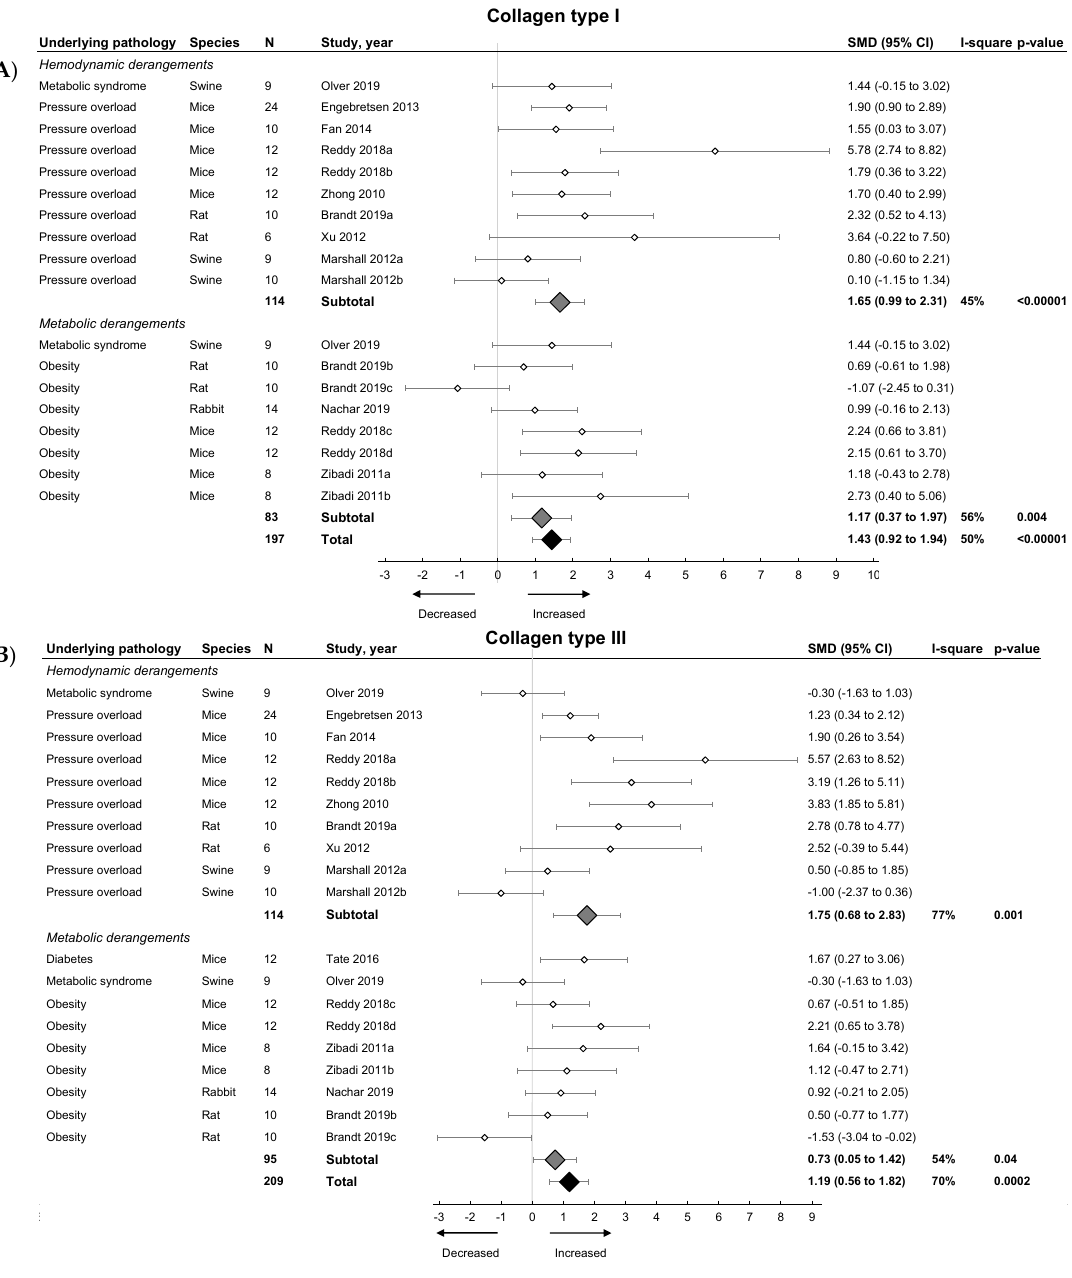
Figure 5. The effect of LVDD/HFpEF on collagen type 1 (panel ( A )) and collagen type 3 (panel ( B )) mRNA levels. Forrest plot; the right side shows an increased effect in LVDD/HFpEF animals, the left side shows a decreased effect in LVDD/HFpEF animals. Data are presented as SMDs with 95% CI. Arrows indicate increased and decreased Collagen type 1 ( A ), and increased and decreased type 3 ( B ) mRNA expression respectively. Only the first author of each study is shown; multiple comparisons within one study are shown with a, b, c or d and correspond with the study overview (Table S1). CI, confidence interval; COL1, collagen type 1; COL3, collagen type 3; I 2 , measurement of heterogeneity; N, cumulative sample size; SMD, standardized mean difference.